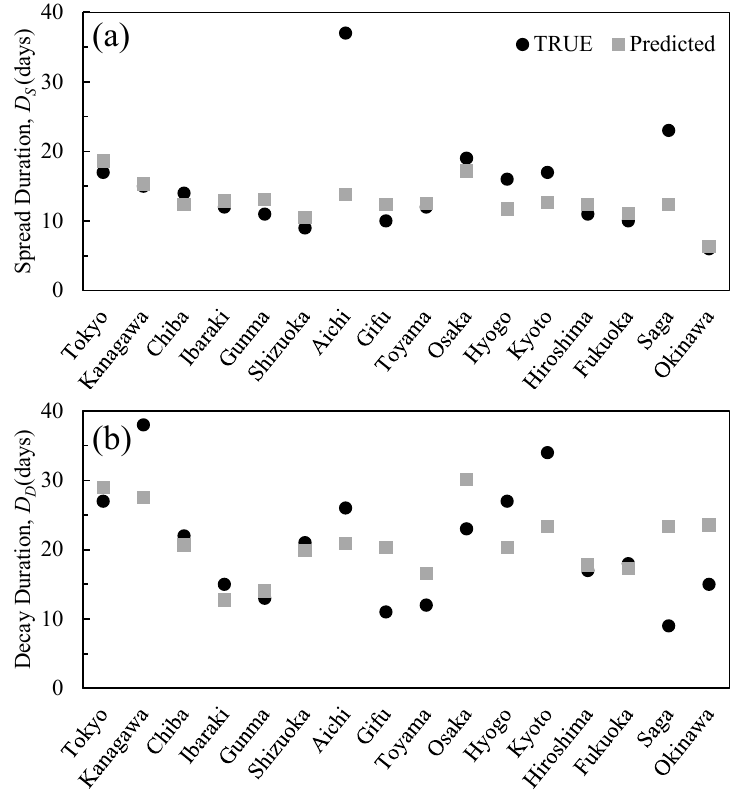
Figure 6. Multivariate regression (population density, maximum temperature, and absolute humidity) results for ( a ) spread and ( b ) decay periods.